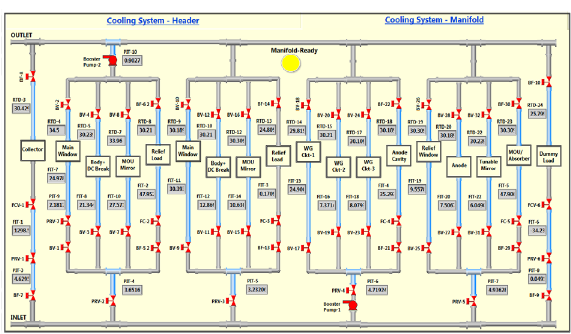
Fig. 19: Flow distribution & other parameters captured